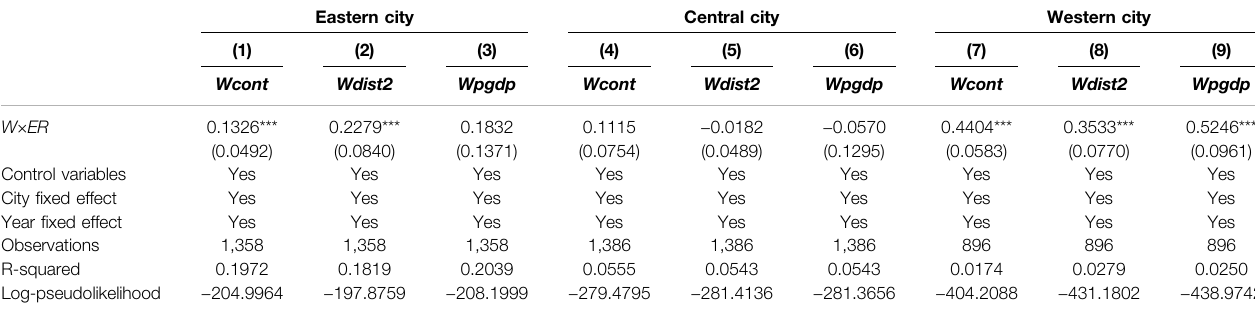
TABLE 5 | Estimates for different